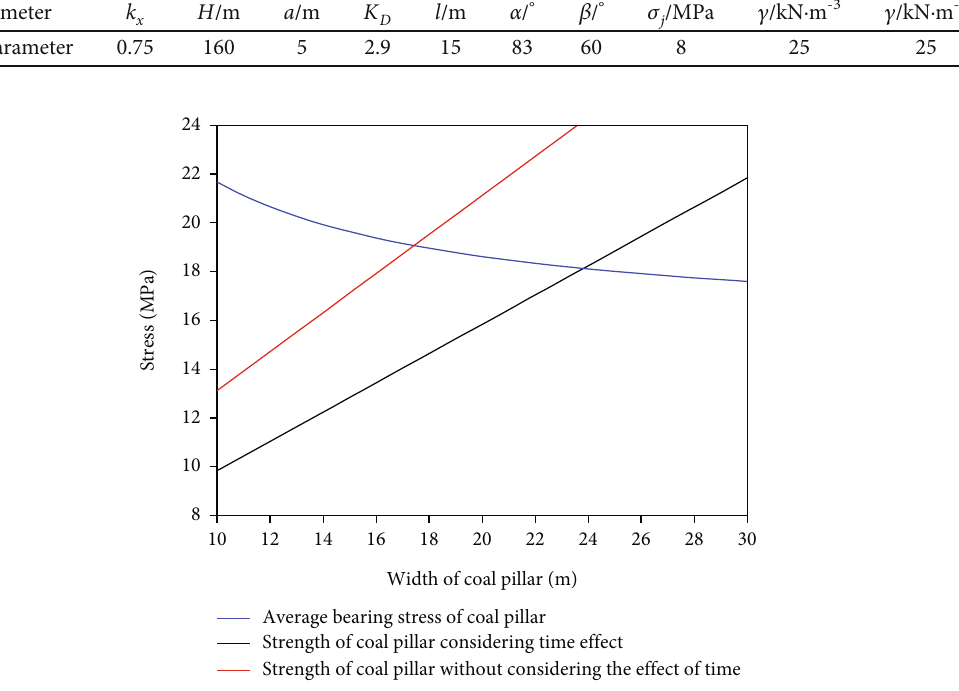
Figure 3: The relationship between the width, strength, and the average stress of the stopping mining coal pillar.